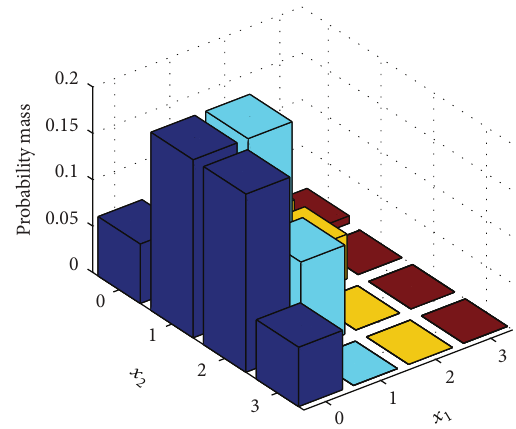
Figure 11: The time and space domain losing packet rate at higher space